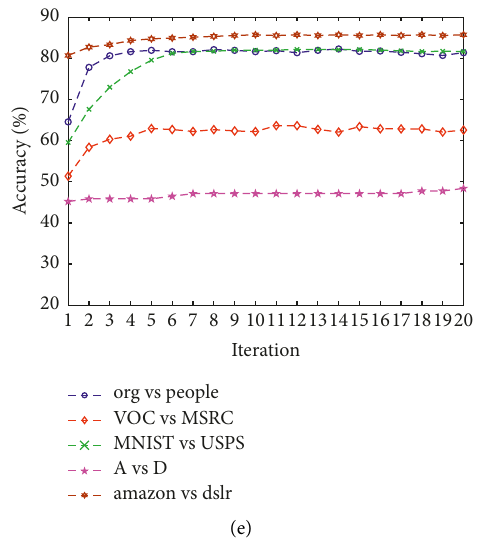
Figure 11: Effect of iteration, number of hidden layer nodes, and parameters α